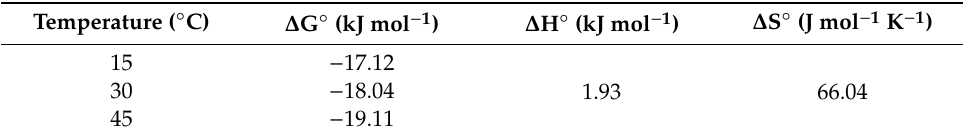
Figure 7. Plot of K C vs 1/T for the estimation of thermodynamic parameters for the adsorption of methylene blue (MB) onto sugarcane bagasse (SCB). methylene blue (MB) onto sugarcane bagasse (SCB). Table 4. Calculated thermodynamic Table 4. Calculated thermodynamic parameters.